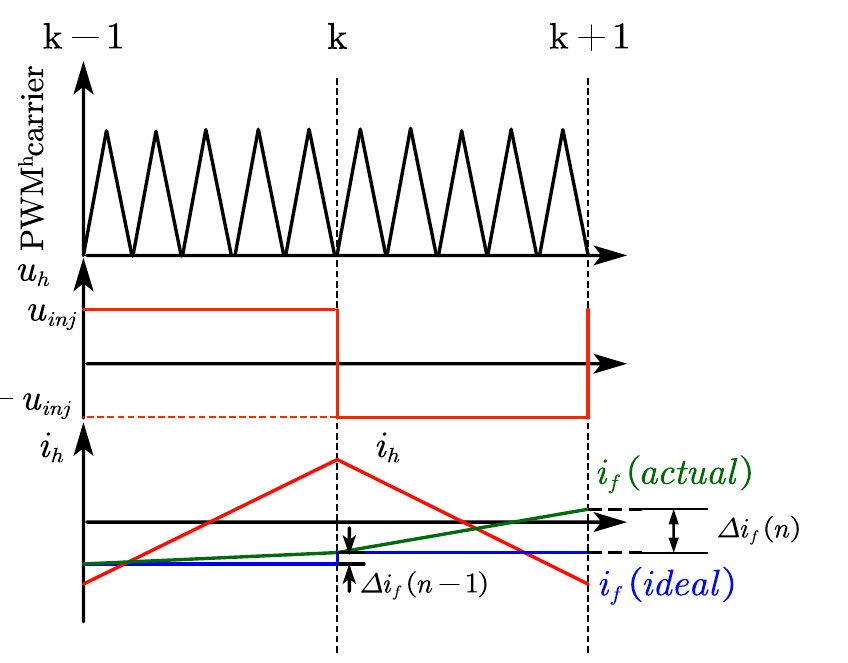
Figure 5. HF square-wave voltage, HF response current, and sampled fundamental current. The dq-axis current, other than the high-frequency response current, can be reason- ably decomposed into (14):